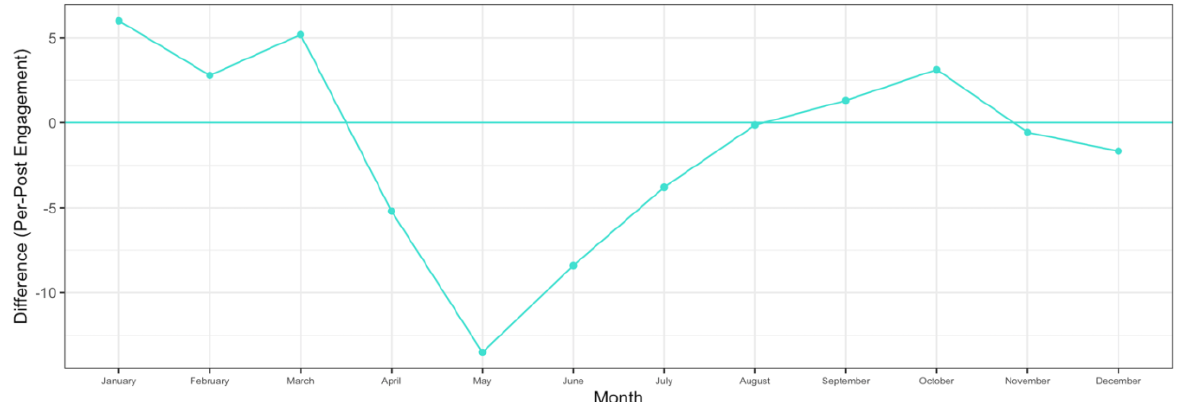
Figure 5. Difference in per-post engagement by users between 2020 and 2019. Each data point represents the difference between 2020 and 2019 in per-post engagement for each month. Total engagement for a month was calculated by adding the total engagement for all fact-checking organizations. Per-post engagement for a month was calculated by dividing the total engagement for the month by the total number of posts (by users and fact checkers) for the